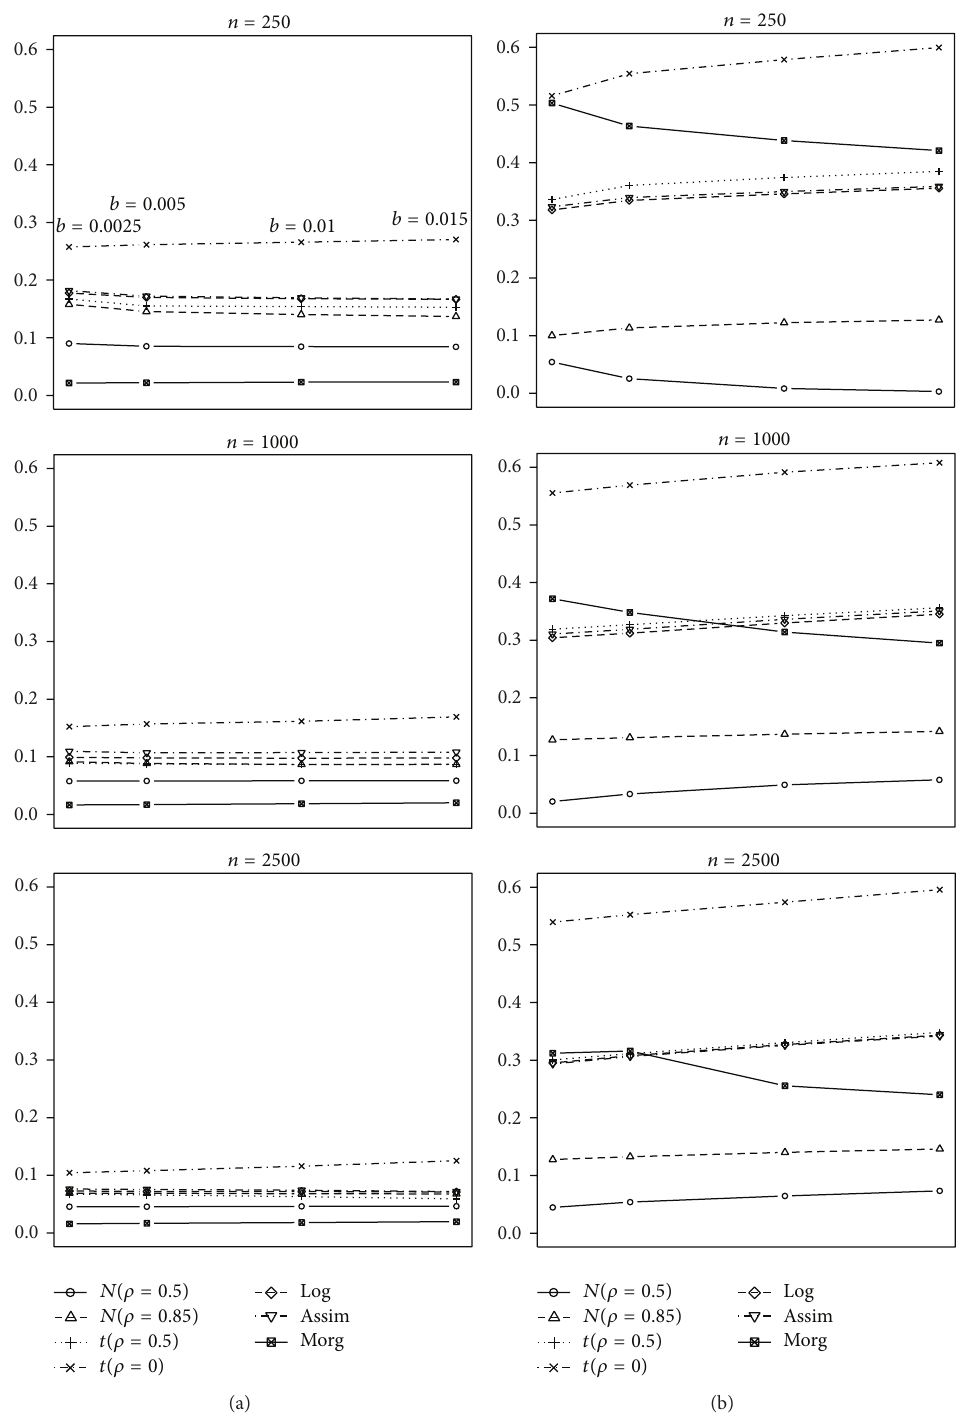
Figure 4: Absolute bias of estimator ̂𝜂 (a) and estimator